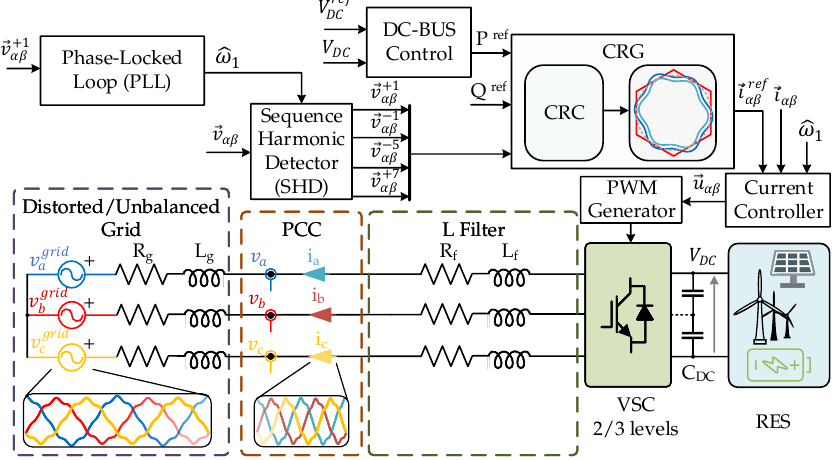
Figure 1. Schematic of the system under study—voltage source converter (VSC) connected to a distorted grid through an